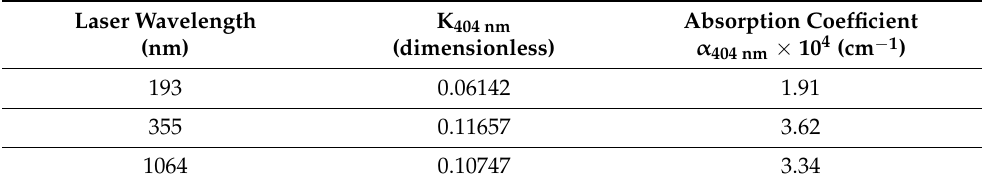
Table 1. The values of extinction coefficient and the absorption coefficient for a specific value of spectroellipsometry (SE) measured wavelength (404 nm).